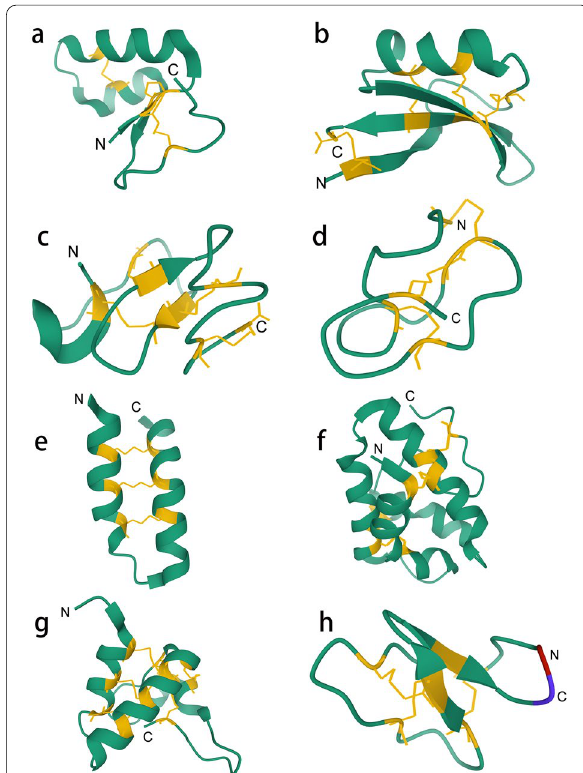
Fig. 2 3D structures of plant AMPs. a thionin from Crambe hispanica subsp . Abyssinica (PDB:3U7T). b plant defensin from Aesculus hippocastanum (PDB:1BK8). c hevein-like peptide from Gypsophila vaccaria (PDB:5XDI). d knottin-type peptide from Hibiscus sabdariffa (PDB:5GSF). e α-hairpinin family peptide from Nigella sativa (PDB:2NB2). f lipid transfer protein from Hordeum vulgare (PDB:3GSH). g snakin from Solanum tuberosum (PDB:5E5Y). h cyclotide from Clitoria ternatea (PDB:2LAM). The N-terminus and C-terminus of the cyclotide are connected. Red represents the N-terminal amino acid and blue represents the C-terminal amino acid. Green represents the amino-acid skeleton. Yellow represents cysteines and disulfide bridges between